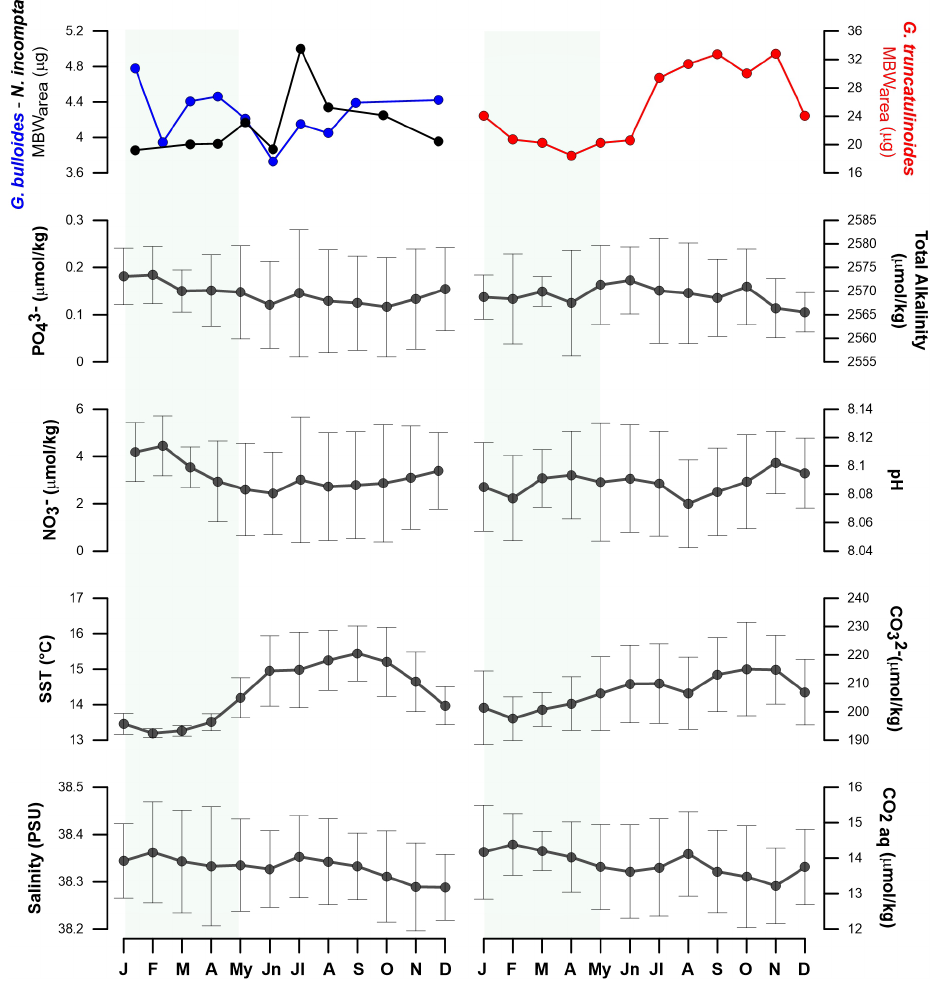
Figure 4. G. bulloides , N. incompta , and G. truncatulinoides seasonal mean monthly MBW area variations compared with Planier environ- mental data and the resampled seasonal signal of environmental parameters from the DYFAMED site across a composite